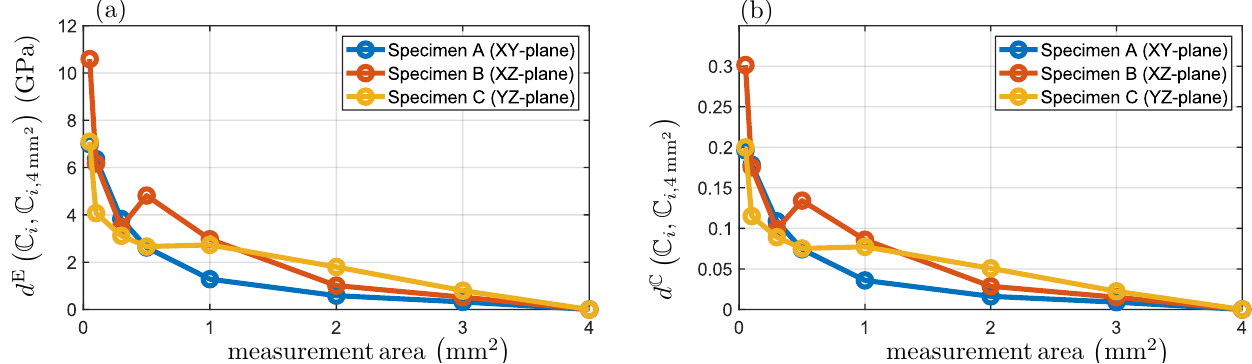
Figure 5. Distance measure d E , shown in ( a ), and distance measure d C , shown in ( b ), between elasticity tensors determined from different measurement areas and the corresponding elasticity tensors determined from measurement areas of 4mm 2 in case of specimen A, B and C. Table 1. Comparison of equivalent grain diameters d observed from measurement areas of 4mm 2 in case of specimens A, B and